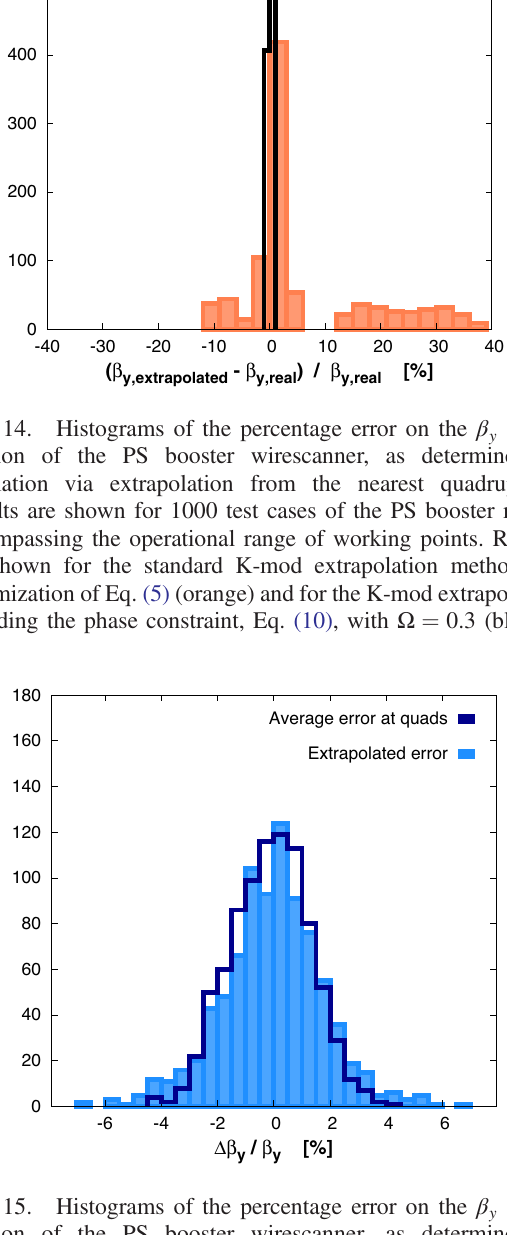
and right quads is indicated).